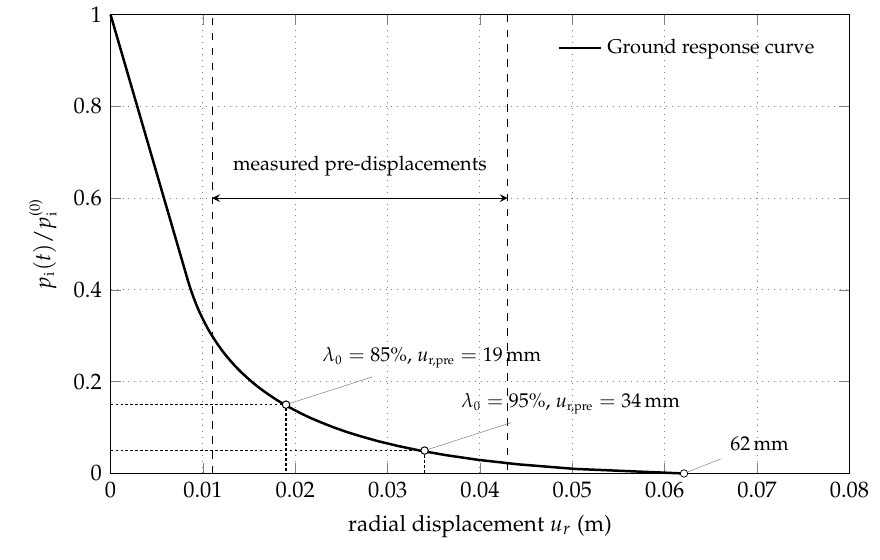
Figure 4. Ground response curve computed on the basis of the Hoek–Brown